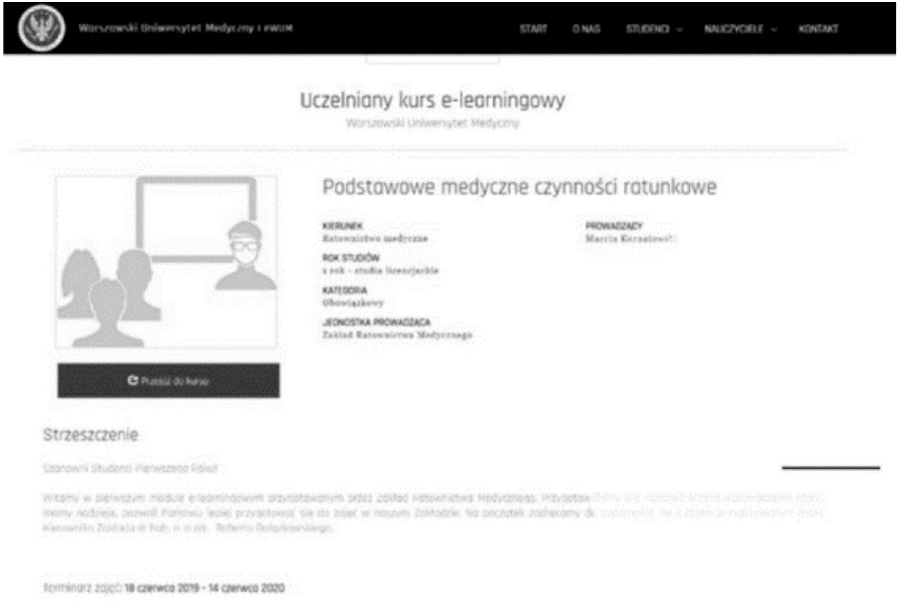
Figure 4. E-learning course at the Medical University of Warsaw E-learning offers full distance learning management options with com- munication and interactive tasks for students. Students can have full or re- stricted access to a subject, where the latter can be gradually opened after passing the consecutive learning stages. The University’s Education Quality and Innovation Bureau, with the support from the IT Division and the Uni- versity E-Learning Workgroup, are responsible for platform management, delivery and